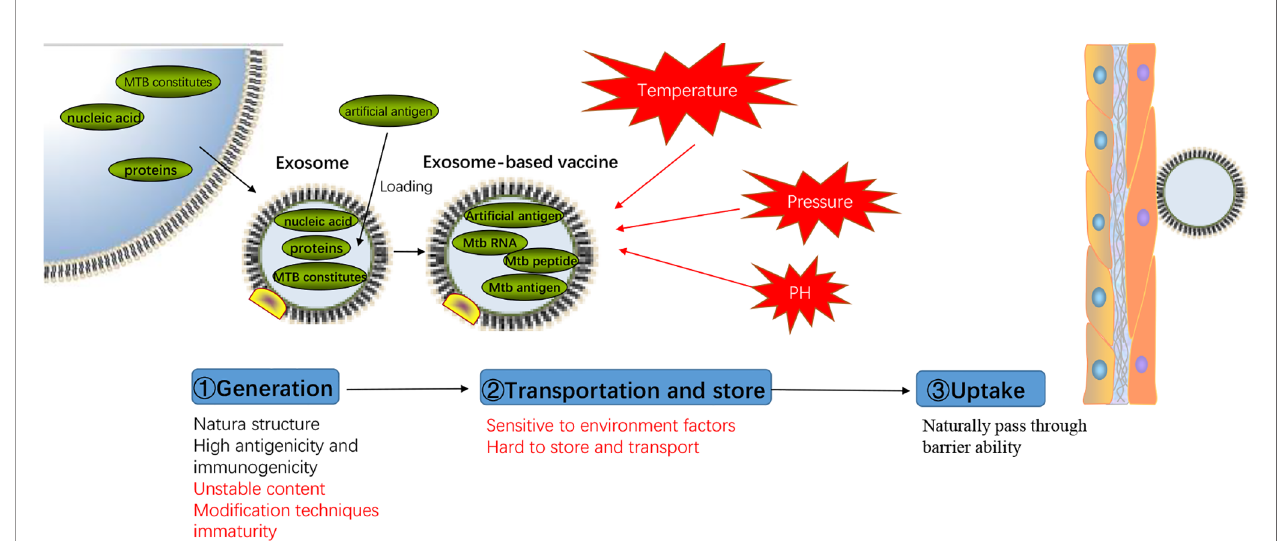
FIGURE 3 | Advantages and disadvantages of exosomes-based vaccine. Representation of the process of exosomes-based vaccine generation, transportation, storage, and uptake with the advantages and disadvantages (mark in red) of each